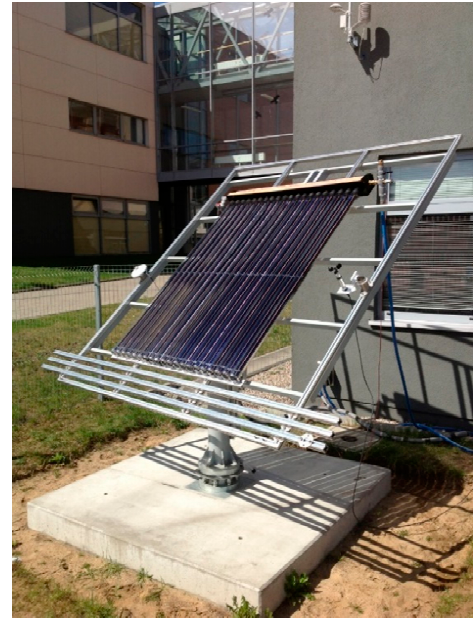
Figure 8. Outdoor platform. Figure 8. Outdoor